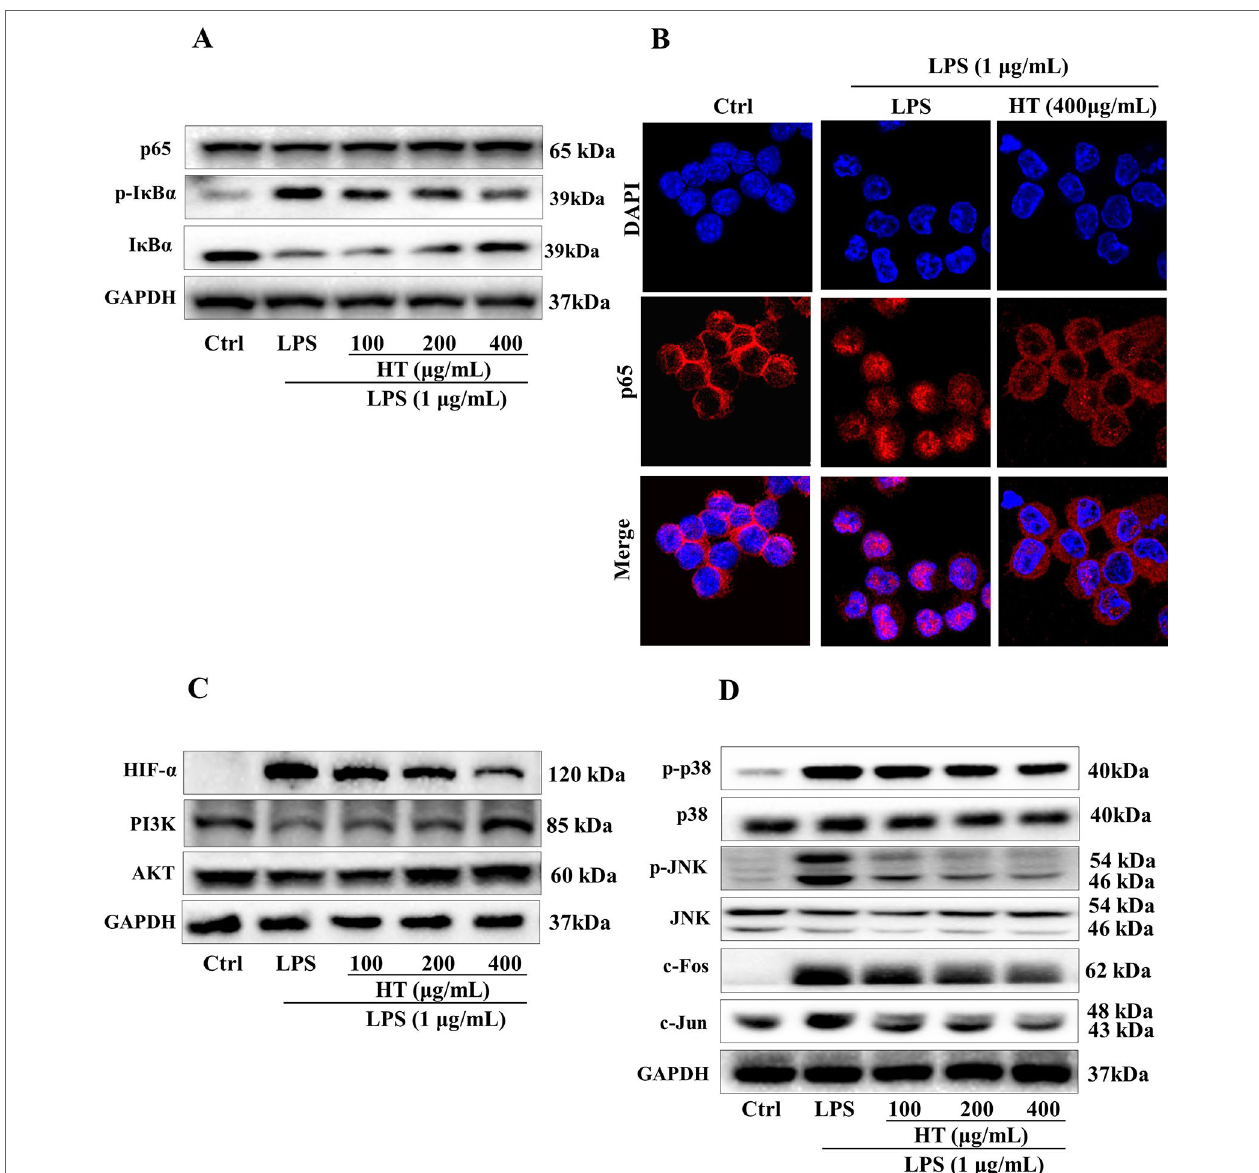
FIGURE 6 | Effects of the HT extract on the relevant proteins in the LPS-induced RAW264.7 cells. Cells were pre-treated with the extract at the concentrations of 100, 200, 400 μg/mL in the 6-well plates for 1 h prior to the stimulation with LPS (1 μg/mL) for 12 h or 1 h, and the relevant proteins deduced from the computational predictions were analyzed by western blotting (A , C and D) and immunofluorescence staining (B)